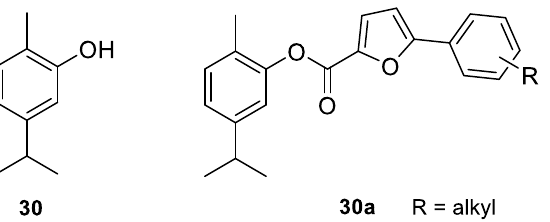
Figure 16. Representative carvacrol derivatives with anticancer activities against Bel-7402 and KB cell lines.